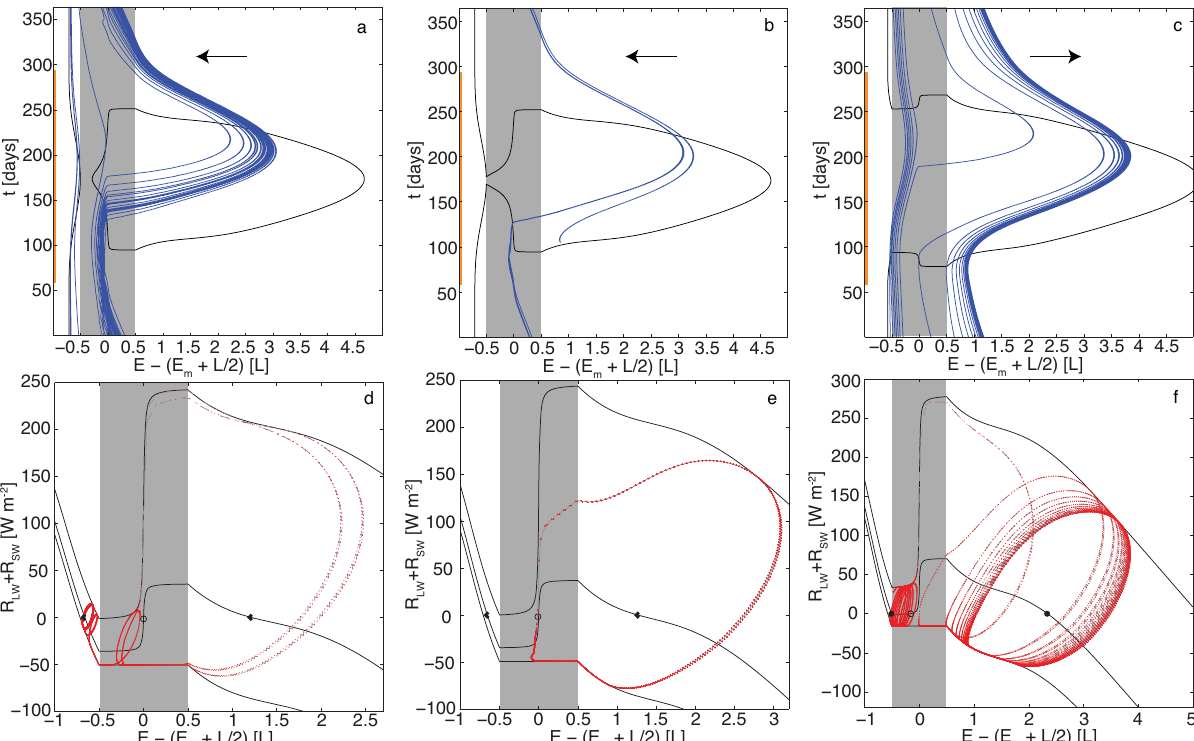
Fig. 6. Top row: annual cycle of the instantaneous fixed points (black curve) resulting from the surface energy budget together with typical system trajectories (blue) for various atmospheric forcing 1b near the onset and near the end of the parameter regime of bistability (Fig. 4b): (a) transition from initially open water to perennial ice ( 1b = 27Wm − 2 ), (b) transition from initially open water to stable seasonal ice ( 1b = 28 . 5Wm − 2 ), and c) transition from an initially frozen ice ocean layer to perennial open water ( 1b = 63Wm − 2 ). The arrow marks the direction of consecutive annual cycles. The vertical red line denotes the time of year when the surface receives solar shortwave radiation (Arctic day). Bottom row: Corresponding panels that show the trajectories of the surface cells (red dots) in the surface cell energy vs surface energy budget space. Consecutive dots cover the same time interval. The black graphs in each panel show the annual maximum, annual average, and annual minimum surface energy budget (from top to bottom) as a function of surface cell energy. The stable (full circle) and unstable fixed points (open circle) resulting from the annual average drive are marked. A video illustrating the motion of the trajectory together with the instantaneous fixed points arising from the time varying surface energy budget is supplied at M¨uller-Stoffels and Wackerbauer